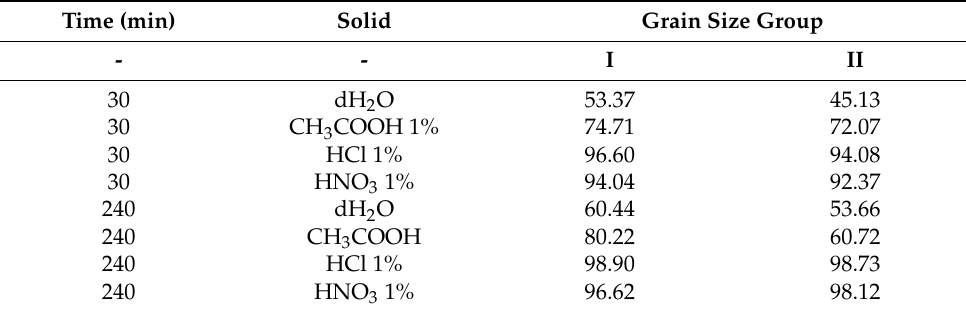
Table 5. Percentage change in ash content in soybean I and II